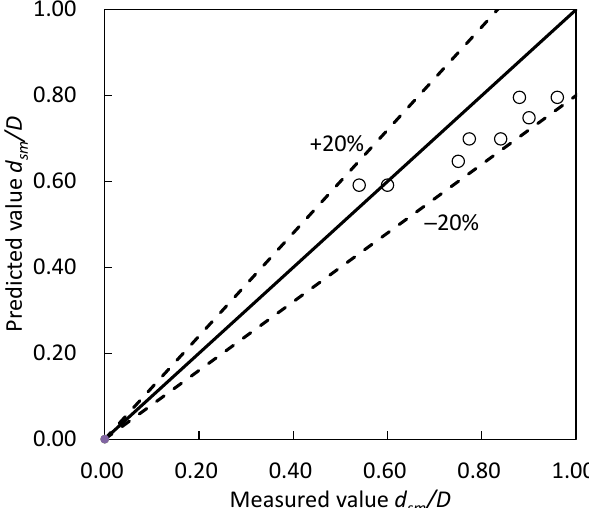
Figure 14. Comparisons of measured and predicted scour depth using Equation (6).